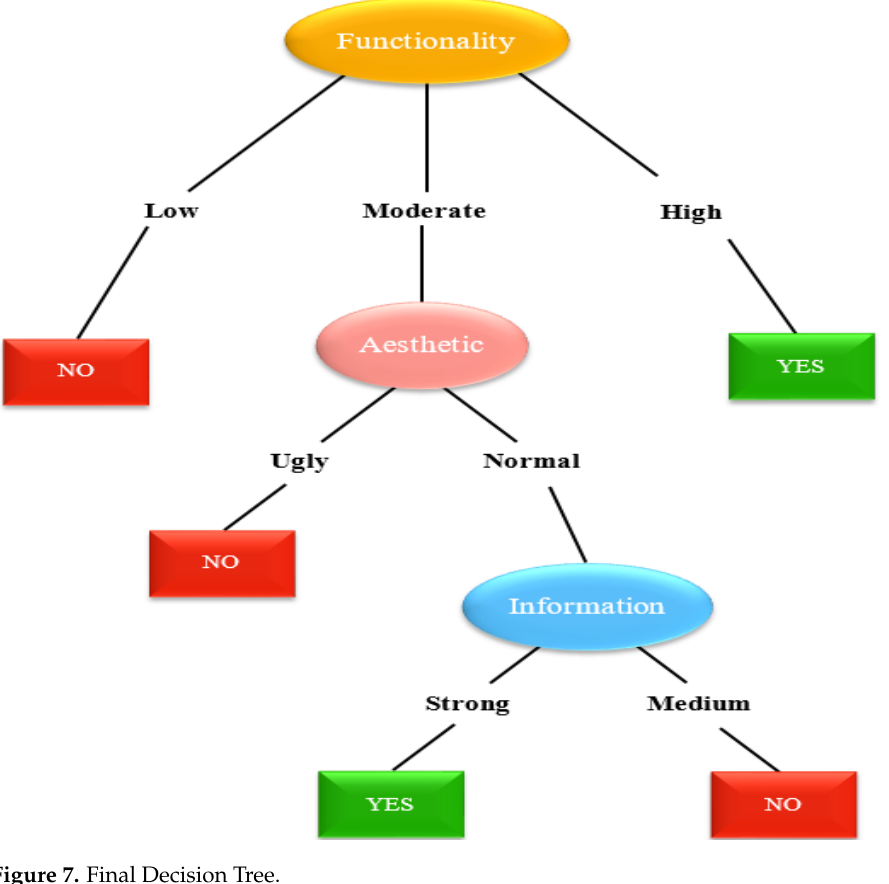
Figure 7. Final Decision Tree.